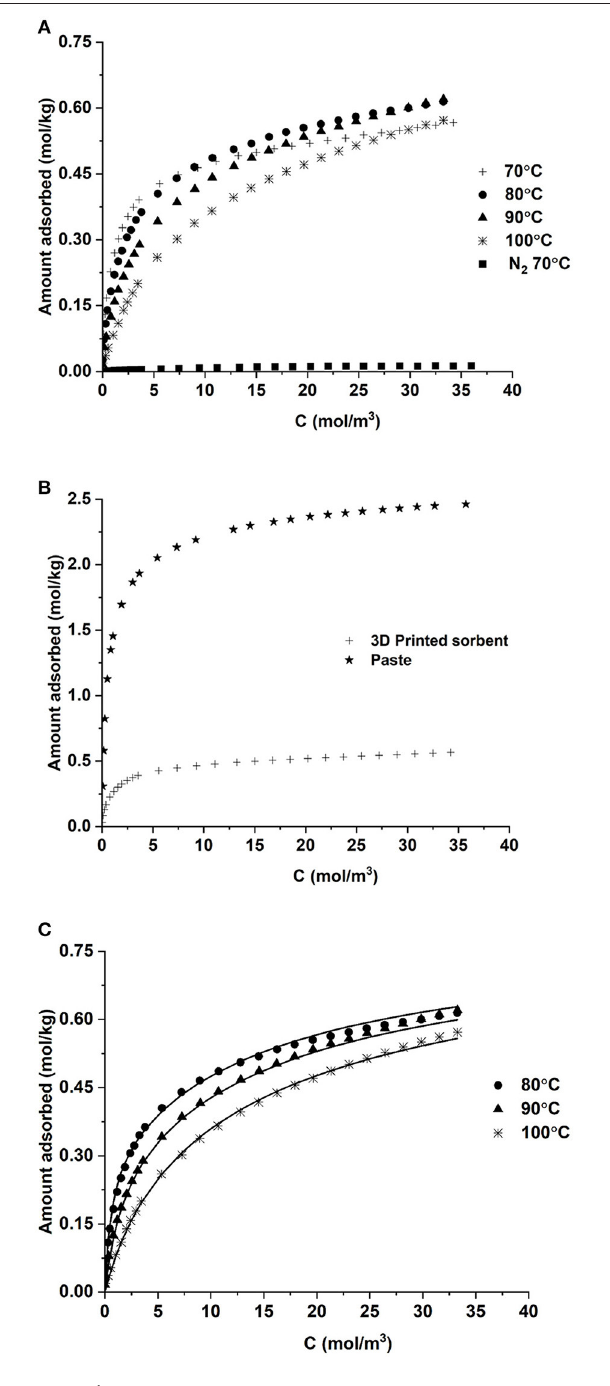
FIGURE 6 | (A) CO 2 and N 2 isotherms in the 3D printed sorbent, (B) comparison of CO 2 isotherms on the printed sorbent and paste and (C) dual-site langmuir isotherm predictions for CO 2